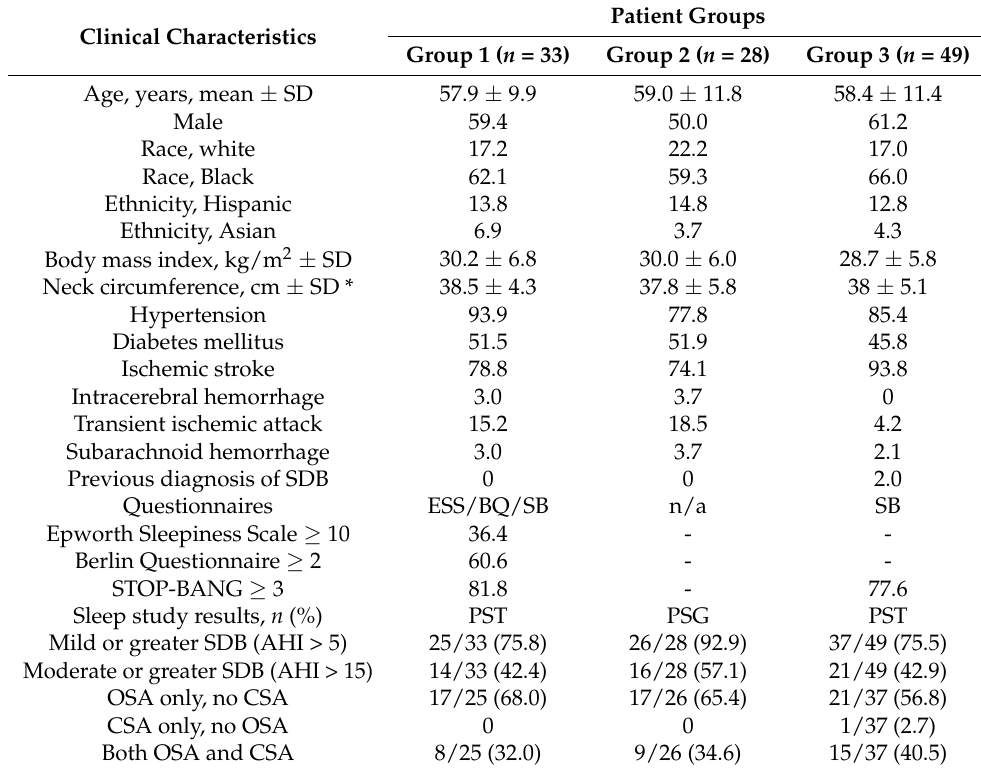
Table 1. Patient Characteristics, Questionnaires, and Sleep Study Results, by Group. Table comparing acute stroke, subarachnoid hemorrhage, and transient ischemic attack patient clinical characteristics, questionnaire results, and sleep study results between: Group 1, patients completing all three questionnaires and a portable sleep test; Group 2, patients completing both a portable sleep test and outpatient polysomnography; and Group 3, patients completing the STOP-BANG questionnaire and a portable sleep test. All numbers displayed are %, unless otherwise specified. Clinical